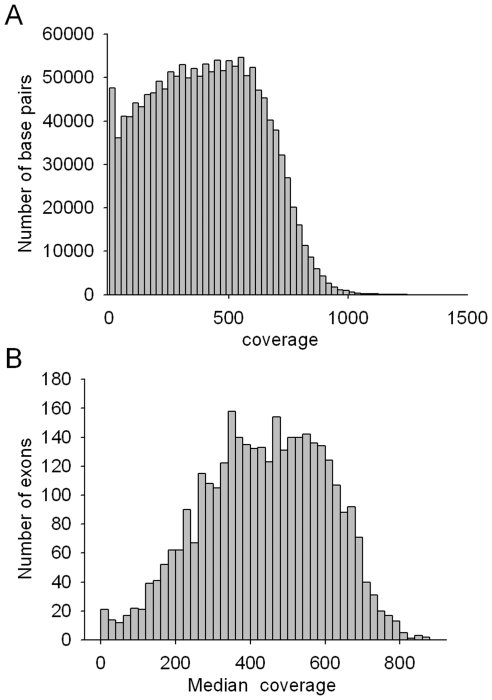
Distribution of sequence coverage.(A) The relationship between sequence coverage and each base pair of the sequenced exons in the 193 genes in YH DNA. (B) The relationship between median coverage and each exon number in all of the 10 samples sequenced in one lane.